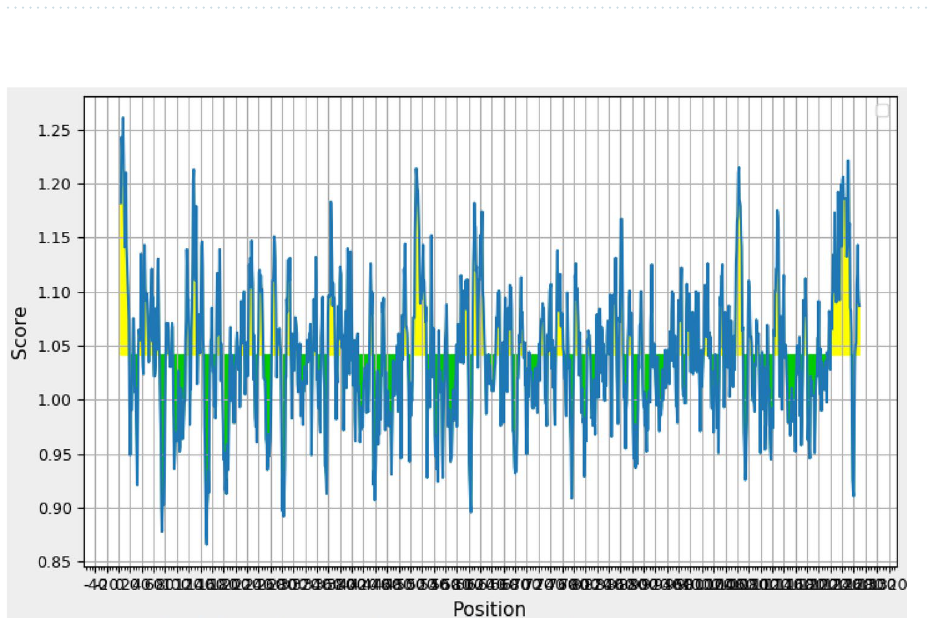
Figure 3. Antigenicity analysis by Kolaskar and Tongaonkar method 33